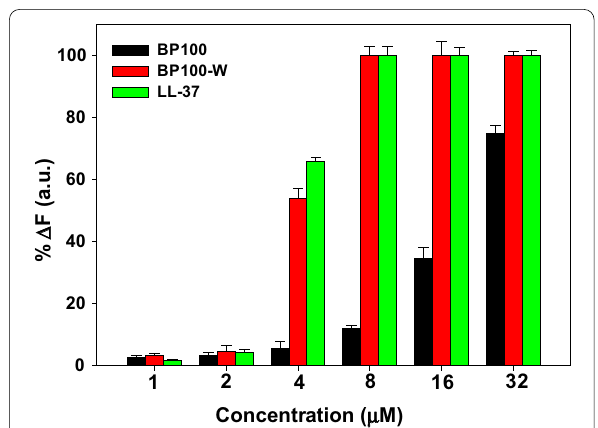
Fig. 7 Binding abilities of BP100, BP100-W and LL ‐ 37 to LPS from Escherichia coli 0111:B4 using boron-dipyrromethene (BODIPY)-TR-cadaverine displacement. Fluorescence intensity was monitored at an excitation wavelength of 580 nm and